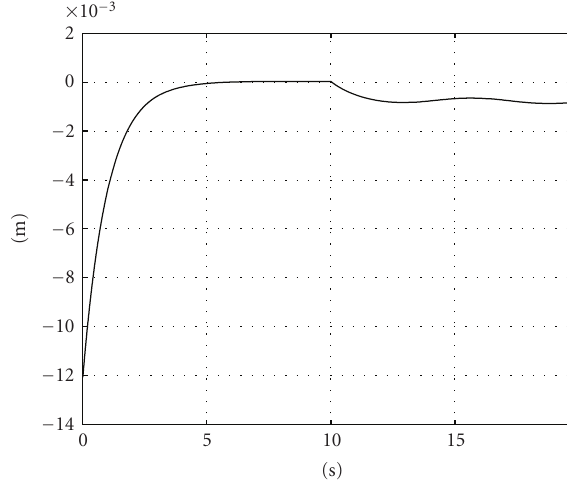
Figure 8: Output error